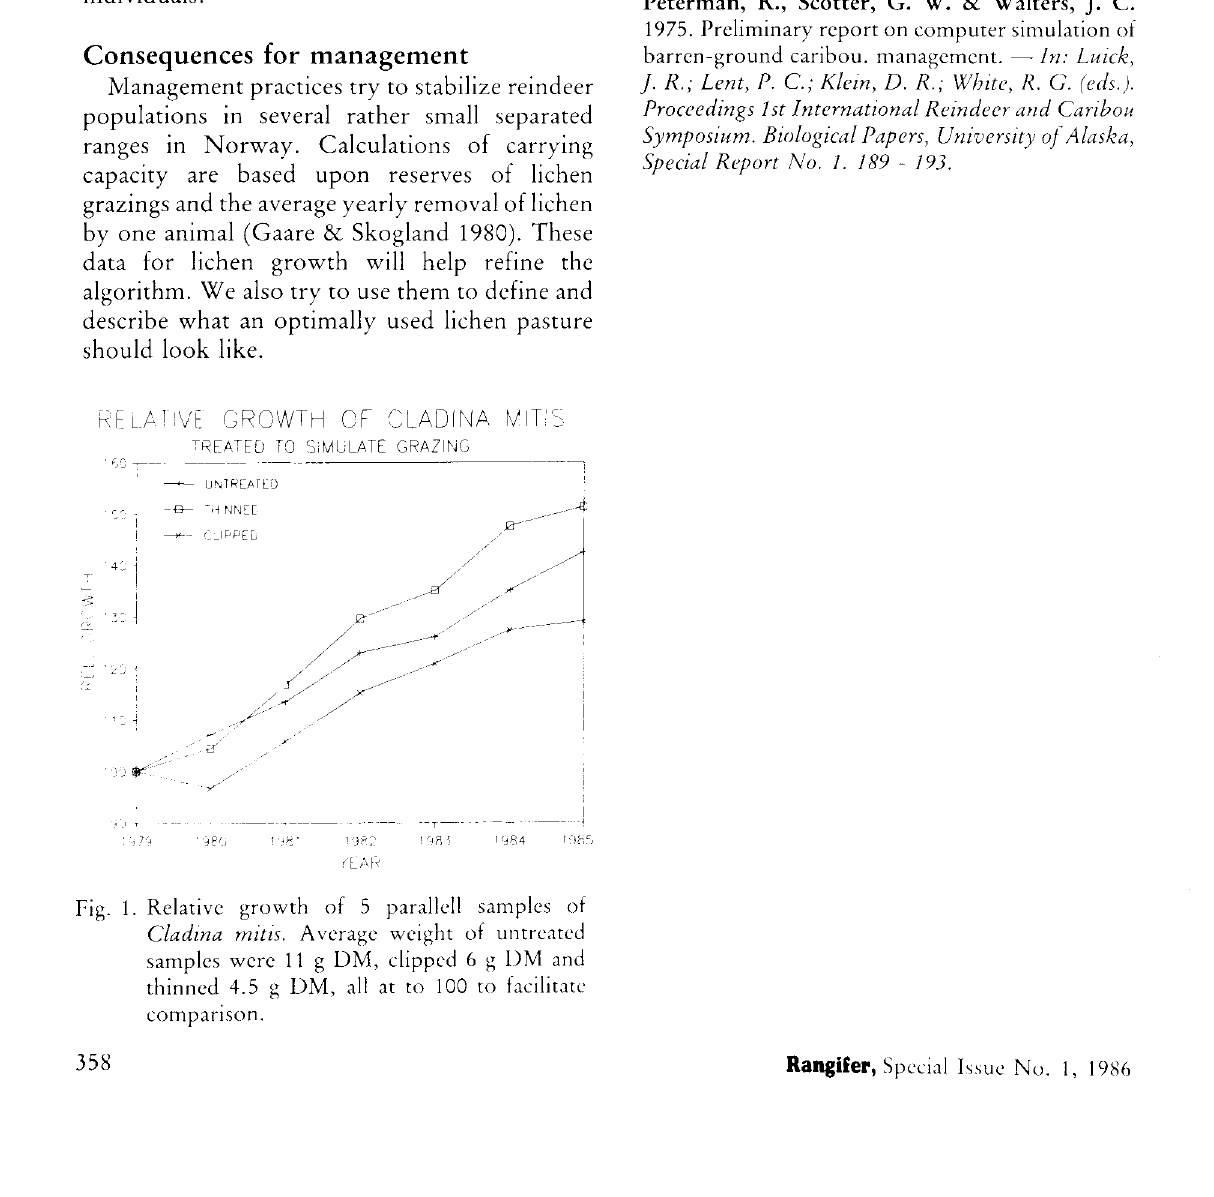
Fig. 1. Relative growth of 5 parallell samples of Cladina mitis. Average weight of untreated samples were 11 g D M, clipped 6 g DM and thinned 4.5 g D M, all at to 100 to facilitate